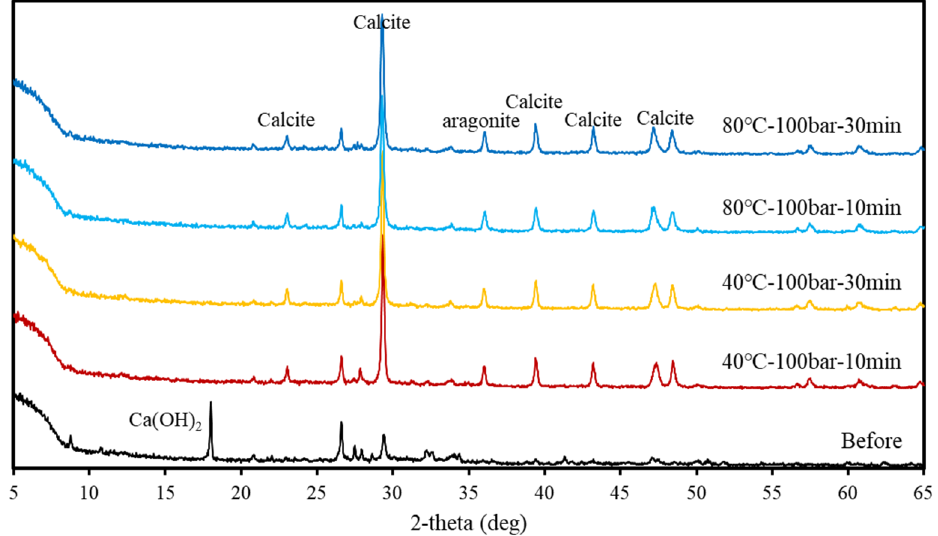
Figure 7. XRD patterns obtained at 100 bar.